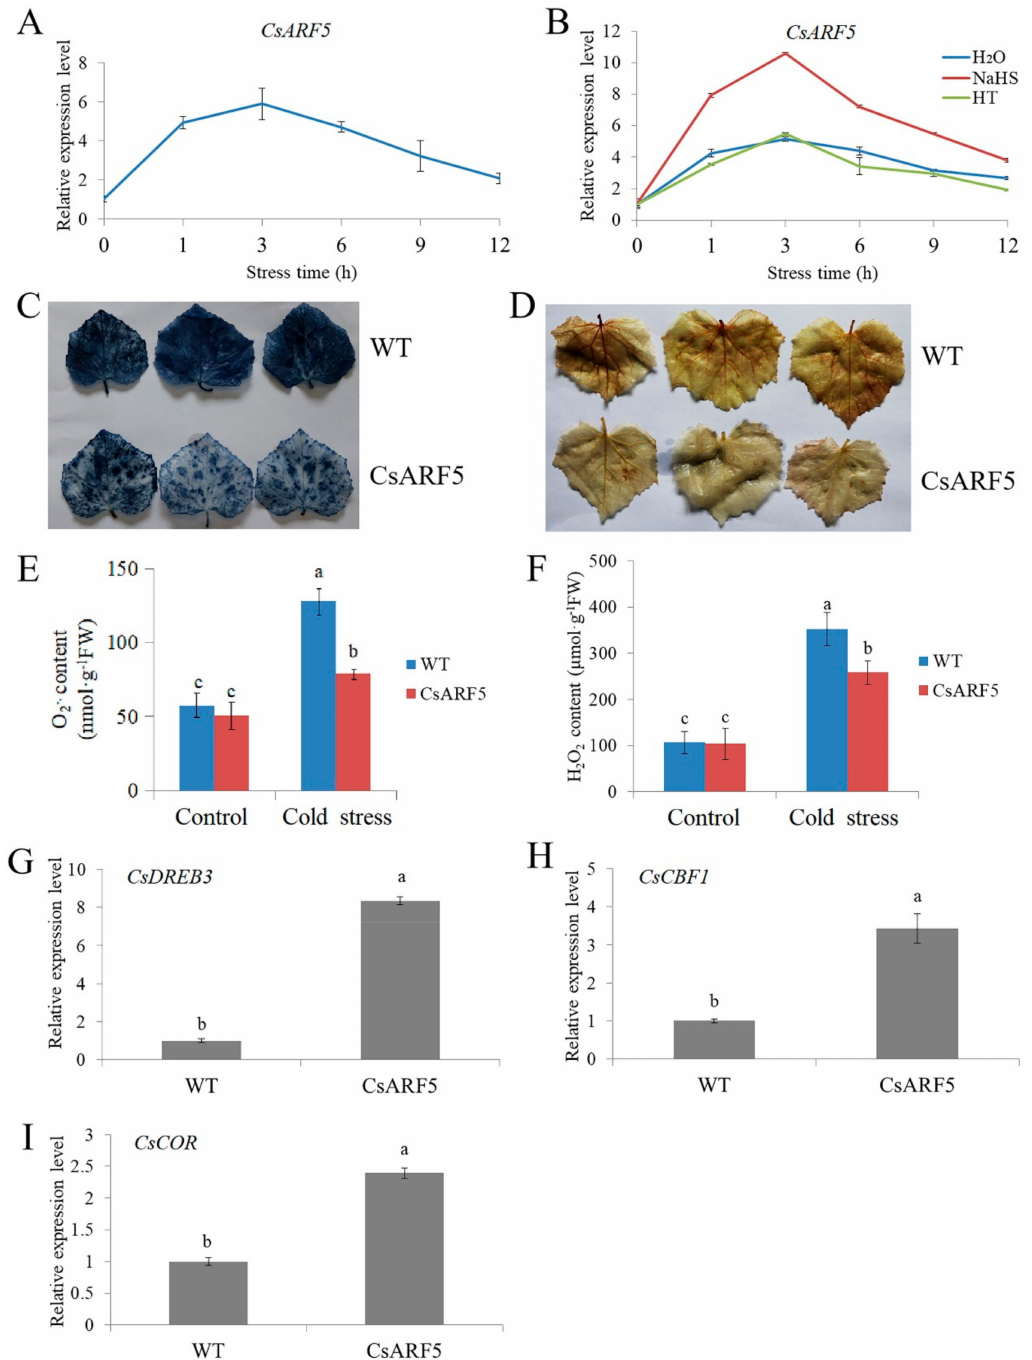
Figure 5. Overexpression of CsARF5 improves cold tolerance of cucumber. ( A ) Expression of the CsARF5 gene in cucumber seedlings under cold stress treatment for 12 h. ( B ) Expression of the CsARF5 gene in cucumber seedlings treated with NaHS or HT under cold stress treatment for 12 h. ( C , D ) NBT and DAB staining of empty vector control (WT) and CsARF5 transient transgenic cucumber leaves treated with cold stress for 12 h. Each genotype contained 5–10 cucumber leaves. The experiments were repeated three times with similar results. A typical picture is shown here. ( E , F ) Detection of O 2 ·− and H 2 O 2 contents of transgenic cucumber leaves before (control) and after cold stress treatment for 12 h. ( G – I ) Expression of CsDREB3 , CsCBF1 and CsCOR genes in transgenic cucumber leaves under cold stress for 3 h. qRT-PCR was performed simultaneously with three biological replicates and three technical replicates. The value of WT was used as the reference and was set to 1. Error bars denote standard deviations. Different letters indicate significant differences ( p < 0.05) based on Duncan’s multiple range